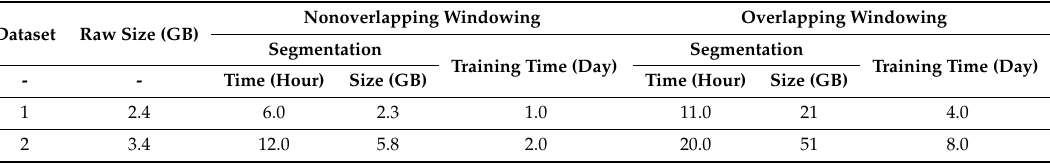
Table 6. Overlapping windowing vs. nonoverlapping windowing required resources-Subject independent CV. Dataset Raw Size